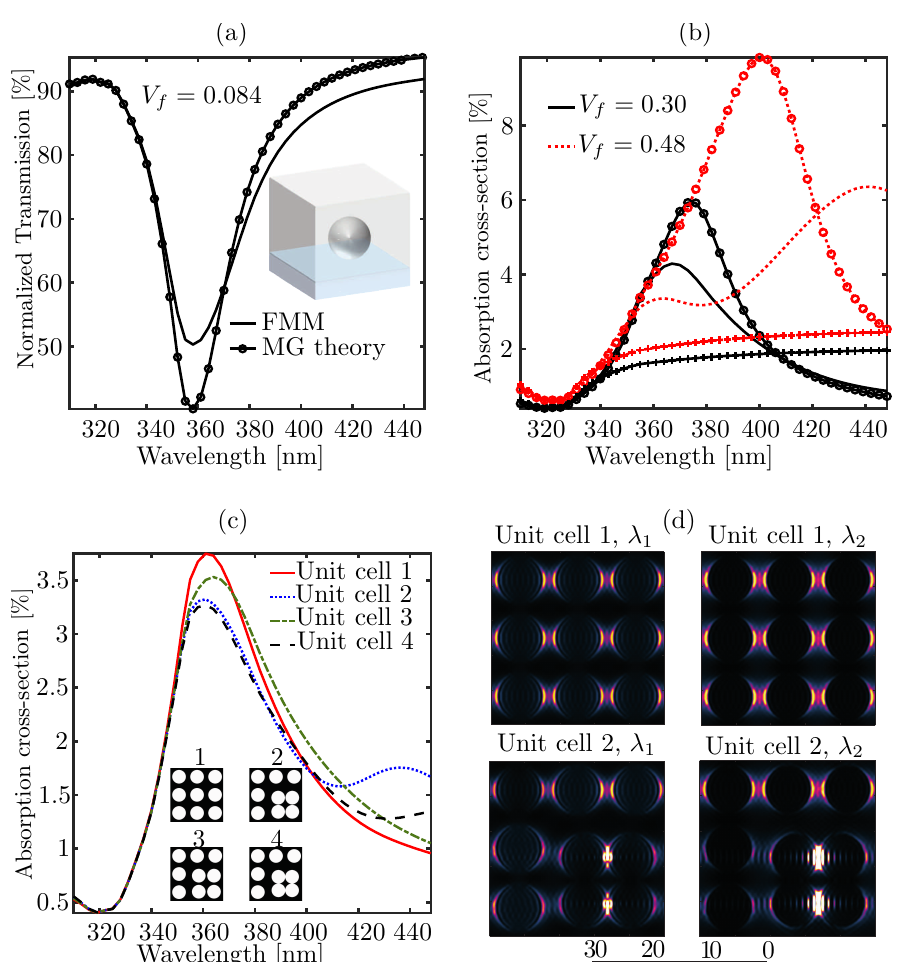
Figure 3. Comparison of the optical properties of a glass-metal nanocomposite (GMN) medium mod- eled with the effective medium approaches and the rigorous grating theory—( a ) spectral efficiency in transmission by a GMN with a low metal (silver) fill fraction of 8.4% ( V f = 0.084) modeled with MG theory and FMM. The shape of the silver inclusions in the host medium (air) is assumed to be spherical. The inset shows the unit-cell of the periodic structure used for the FMM-based approach. ( b ) Absorption cross-section spectra of a similar GMN monolayer with two different and relatively higher (as compared to that used in ( a )) metal inclusions of 30% (solid black lines) and 48% (dotted red lines) respectively, modeled with MG theory (marker type—open circles ‘ ’), Brueggemann ◦ theory (marker type—diamonds ‘ (cid:7) ’), and FMM (no marker), ( c ) absorption cross-section spectra of a monolayer GMN with V f = 0.3 calculated with FMM for four different unit-cell configurations (cross-sections through the equators of the nanospheres) as shown in the inset. Each unit-cell contains nine silver nanospheres. The unit-cell configuration 1 is identical to the example included in ( b ). Specifically, the solid red curve in ( c ) is identical to the solid black curve in ( b ), ( d ) E -field energy density distributions across the cross-sectional planes through the equators of the silver spheres for unit-cell configuration 1 at λ 1 = 363 nm (upper row left) and λ 2 = 435 nm (upper row right). Similar plots for unit-cell configuration 2 at λ 1 (lower row left) and at λ 2 (lower row